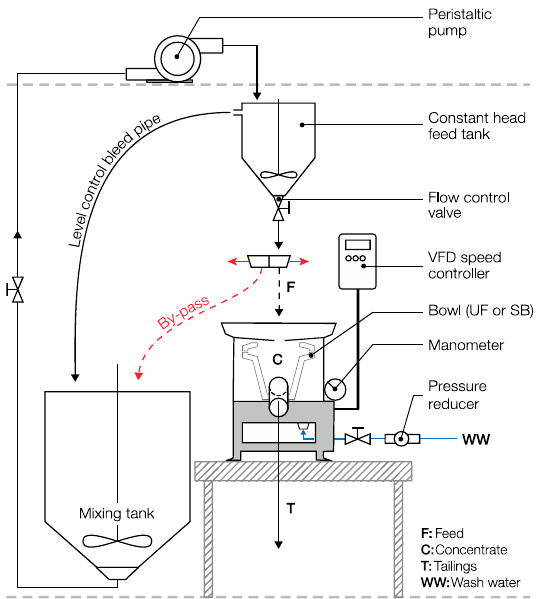
Figure 2. Experimental setup for Falcon L40 testing. Note that wash water (WW) is only used for Falcon SB testing.